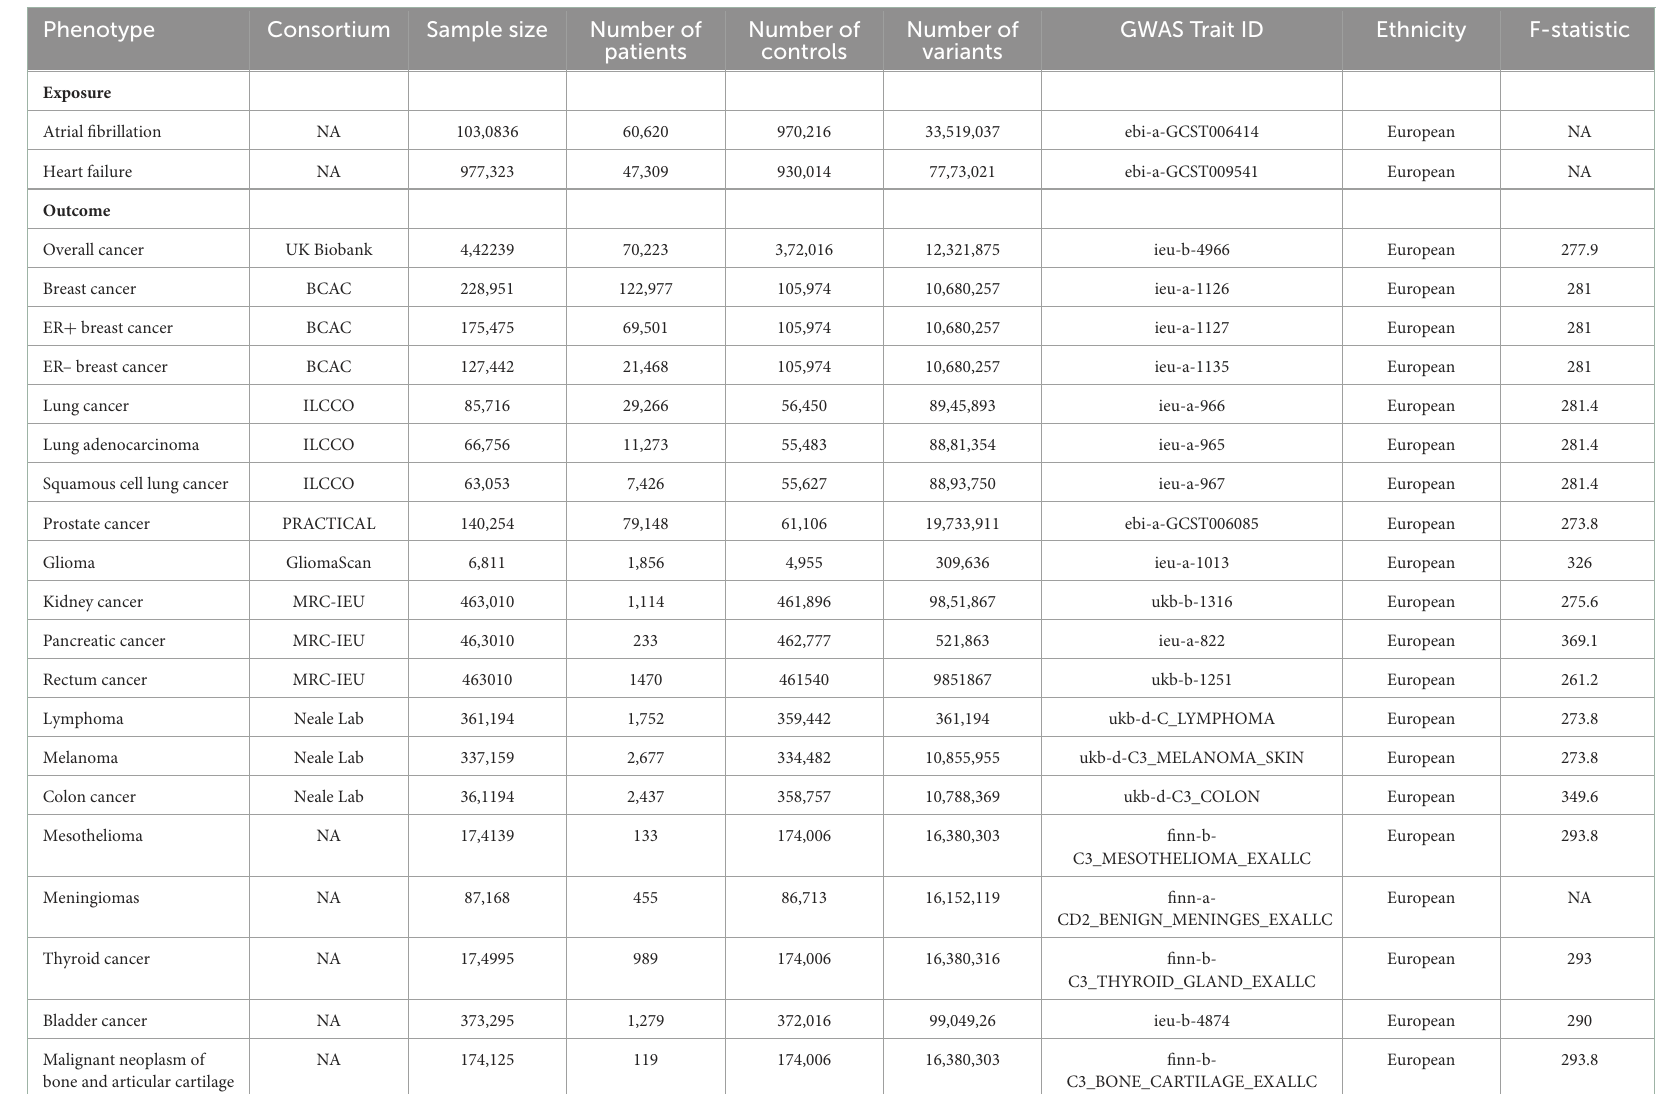
TABLE 1 Details of studies in the present Mendelian randomization